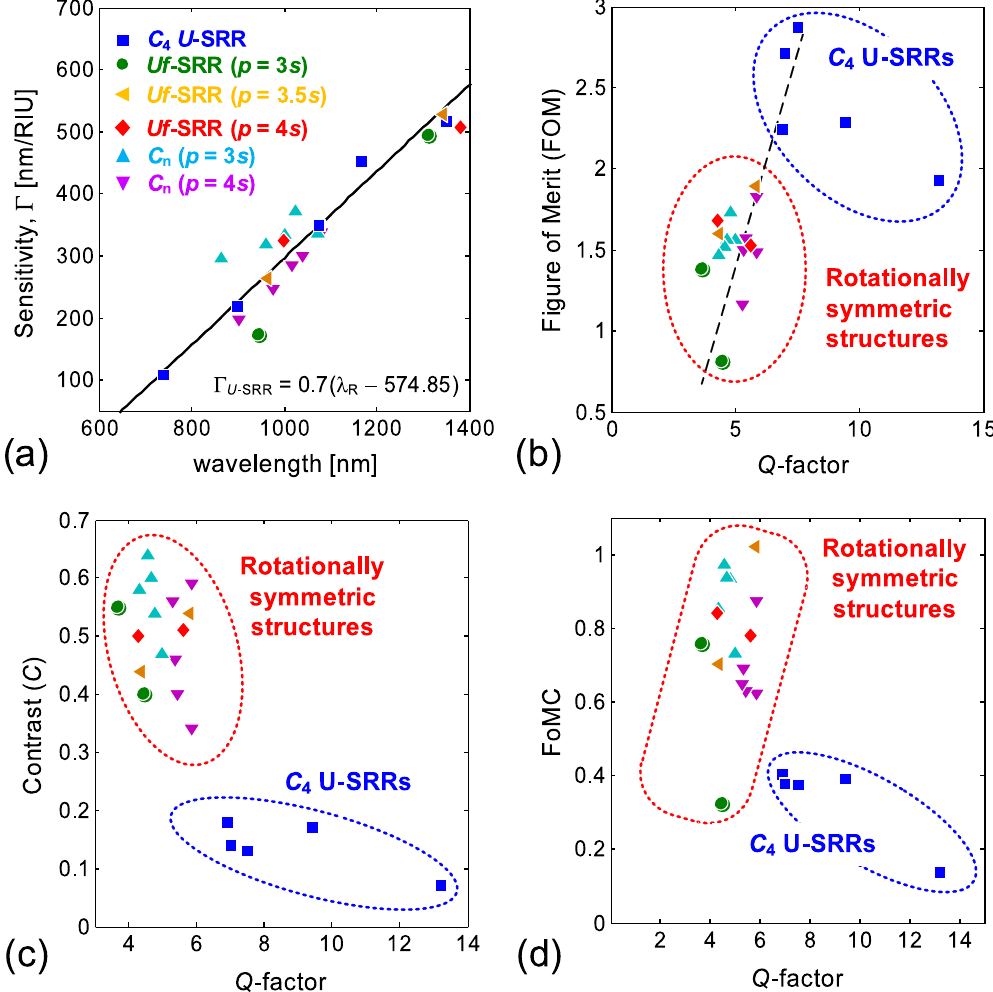
Figure 9. Sensing performances of C 4 U-SRR, Uf-SRR, and C n structures based on unpolarized light. ( a ) Sensitivity as a function of resonance wavelength, ( b ) Figure-of-Merit as a function of Q-factor, ( c ) Spectral contrast as a function of Q-factor, and ( d ) Modified Figure-of-Merit (FoMC) as a function of Q-factor. The solid line in ( a ) is the linear fitting of Γ SRR ( λ R ), while the dashed line in ( b ) is a guide line depicting the FoM ∝ Q relation. The shaded areas in ( b )–( d ) group the C 4 U-SRRs and rotational symmetric structures (Uf-SRR and C n